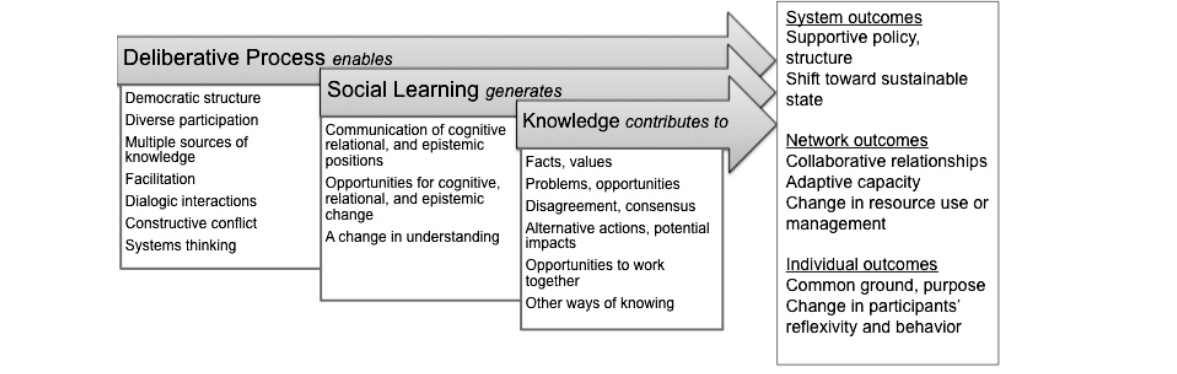
Fig. 1 . Adapted from Schusler et al. (2003) and integrates concepts from Blackmore (2007), Conley and Moote (2003), Muro and Jeffrey (2008, 2012), Reed et al. (2010), and Rodela (2011). Illustrates the process conditions that enable individual-level social learning, which generates new knowledge and understanding that can contribute to multiple outcomes at individual, network, and system